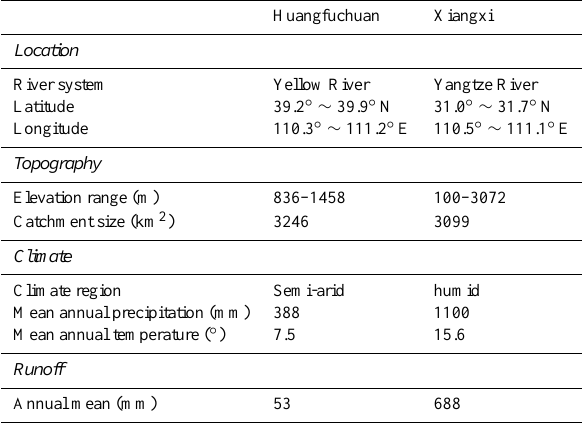
Table 1. Characteristics of the study